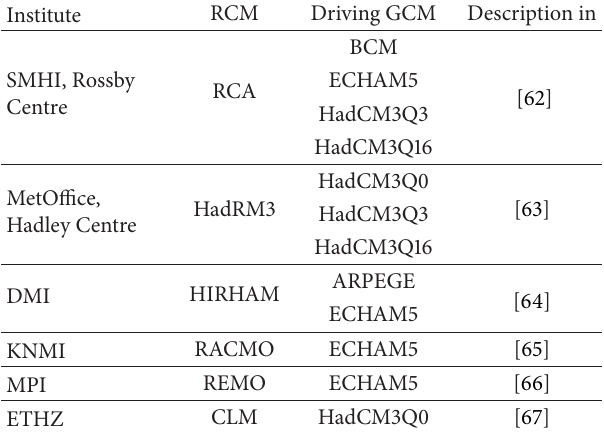
Table 1: Regional climate model simulations used and their basic